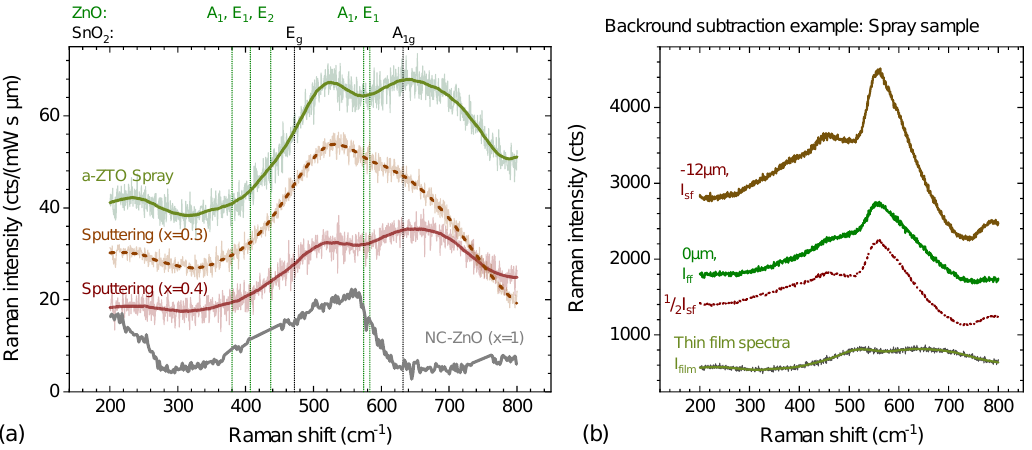
Figure 5. ( a ) Background subtracted Raman spectra of a-ZTO films grown by magnetron sputtering and spray pyrolysis. The Raman spectra are dominated by two broad modes at 500 and 650cm − 1 . Higher tin content leads to an increase of the amplitude of the 500cm − 1 mode. The spectra of the spray pyrolysis sample is very similar to the one of the sputtered sample with x = 0.4 suggesting it has a similar Zn content. The gray spectra is an Al-doped ZnO sample with high Al content (8%) indicative of nanocrystalline ZnO (for more details see Section 5); ( b ) example of raw data ( I ff , I sf ) and background-subtracted data I film for the Spray pyrolysis sample. In contrast to the CuO x case raw spectra are dominated by the glass substrate Raman spectra and only subtle changes in line shape indicate the presence of the